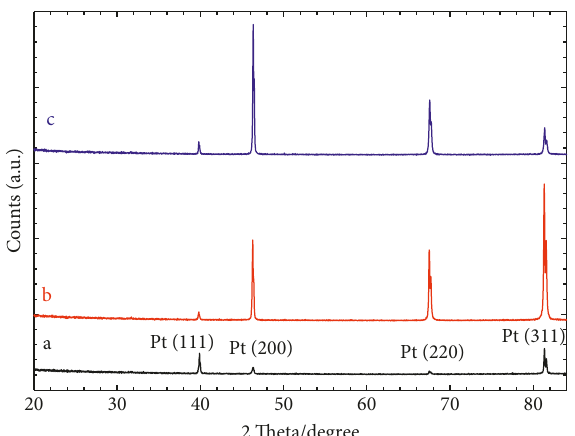
Figure 4: XRD spectra of the bare Pt (a), FeOx/Pt (b), and a-FeOx/ Pt ( − 0.5 V) (c) and the highest negative shift (ca. − 30 mV) in the onset potential of FAO (Table 2). Pursuing the activation at − 1.3 V came in the second place (after − 0.5 V) with an I pd / I pind ratio of 10.6 (i.e., fivefold enhancement) and a negative shift (ca. − 13 mV) in the onset potential of FAO. Activating the FeOx/